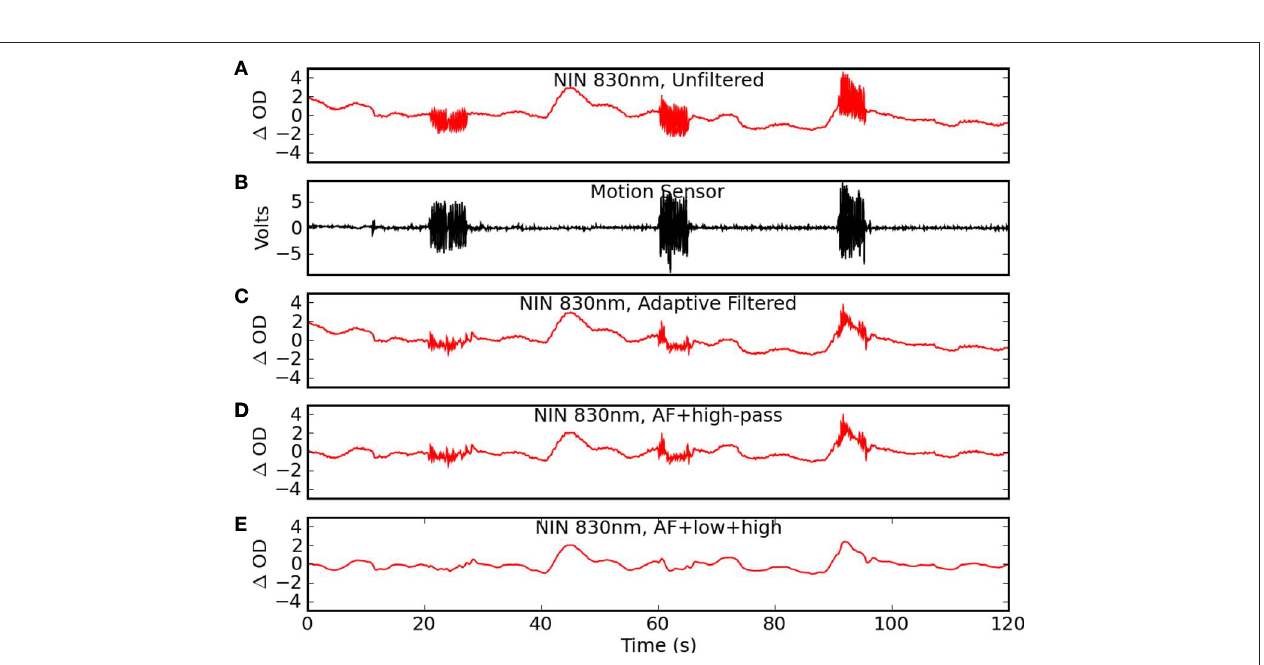
FIGURE 3 | Graphical depiction of channel by channel SNR, computed as mean signal intensity divided by the SD of signal intensity over time (S = source position, D = detector position). Source–detector pairs with SNR > 50 are connected with green lines, while those with lower SNRs are